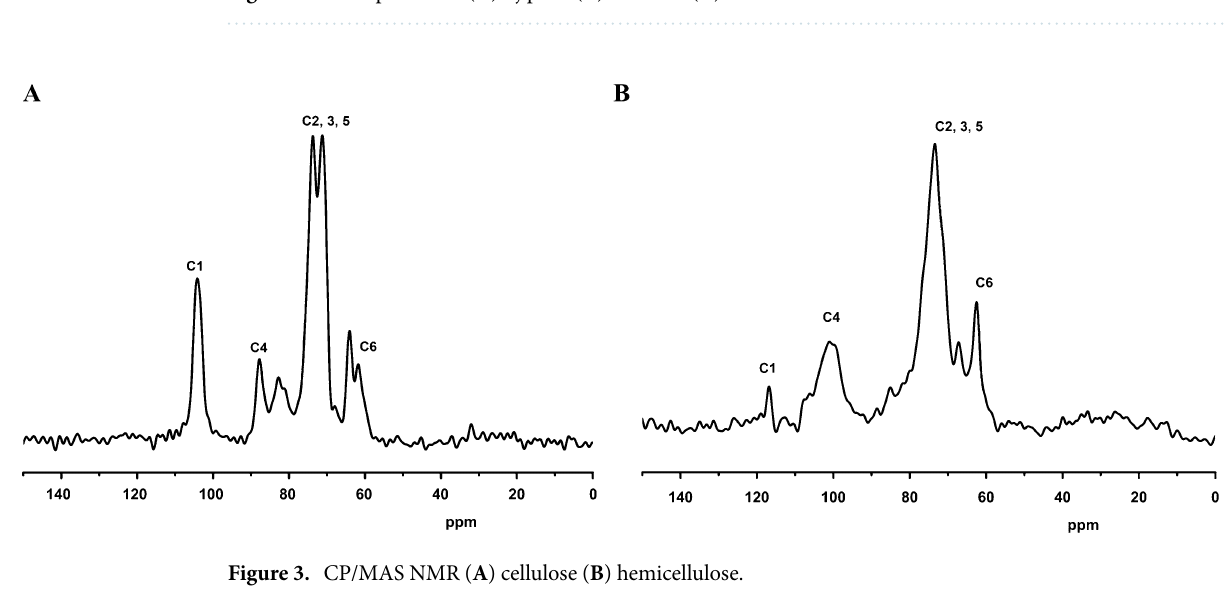
Figure 2. FTIR pattern of ( A ) Pj pods ( B ) cellulose ( C ) hemicellulose.